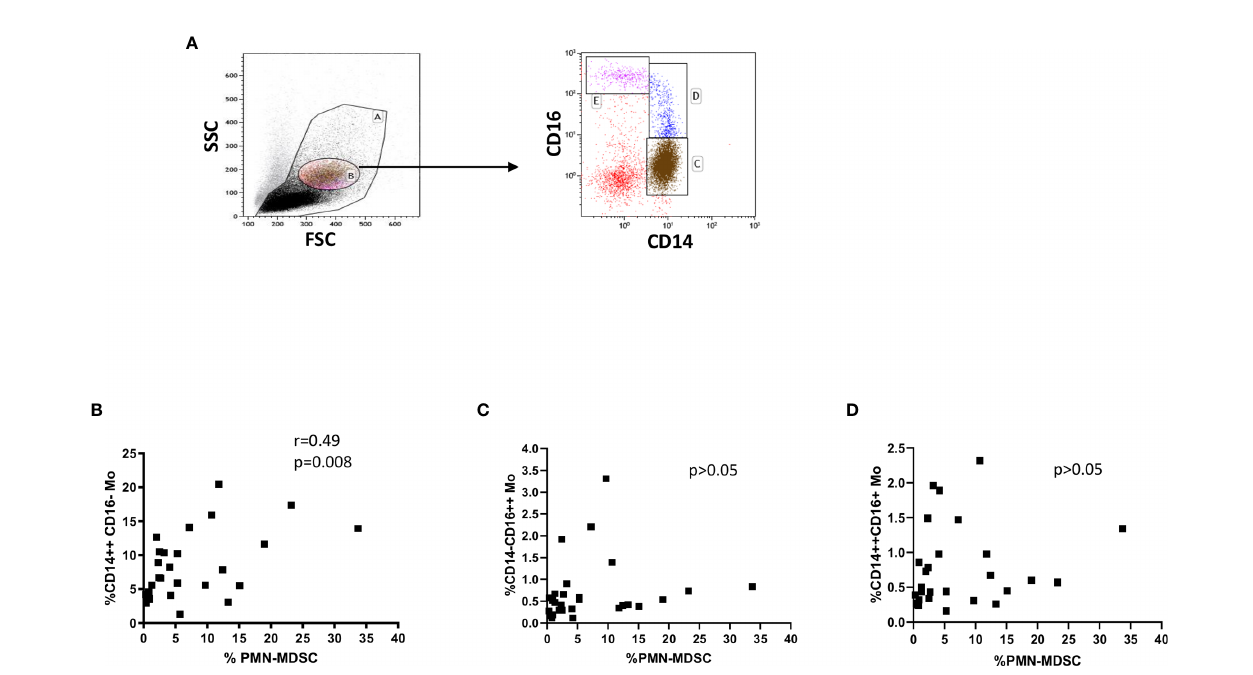
FIGURE 3 | PMN-MDSC frequency correlates with the CD14++CD16- monocyte proportion. (A) Gating strategy used to identify monocyte subsets: in the morphological gate (FSC/SSC) we excluded debris gate (A), and morphologically identi fi ed monocytes gate (B). In gate B, we selected CD14++CD16, CD14++CD16+, and CD14-CD16++ monocytes. The percentage of monocyte subsets was calculated in the gate (A) Correlation between PMN-MDSC frequency and CD14++CD16 (B) , CD14++CD16+ (C) , and CD14-CD16++ (D) monocytes from active TB and LTBI subjects. The Spearman test was applied to evaluate correlations. The p <0.05 was considered statistically signi fi cant.